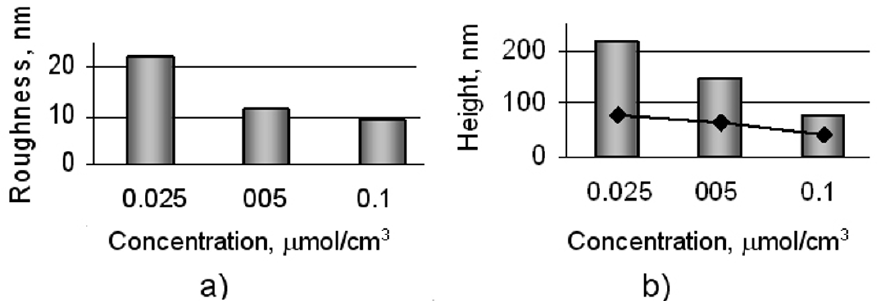
Figure 12. Dependence of layer mean square roughness (a) and height (b) on the concentration of K temperature of 20oC